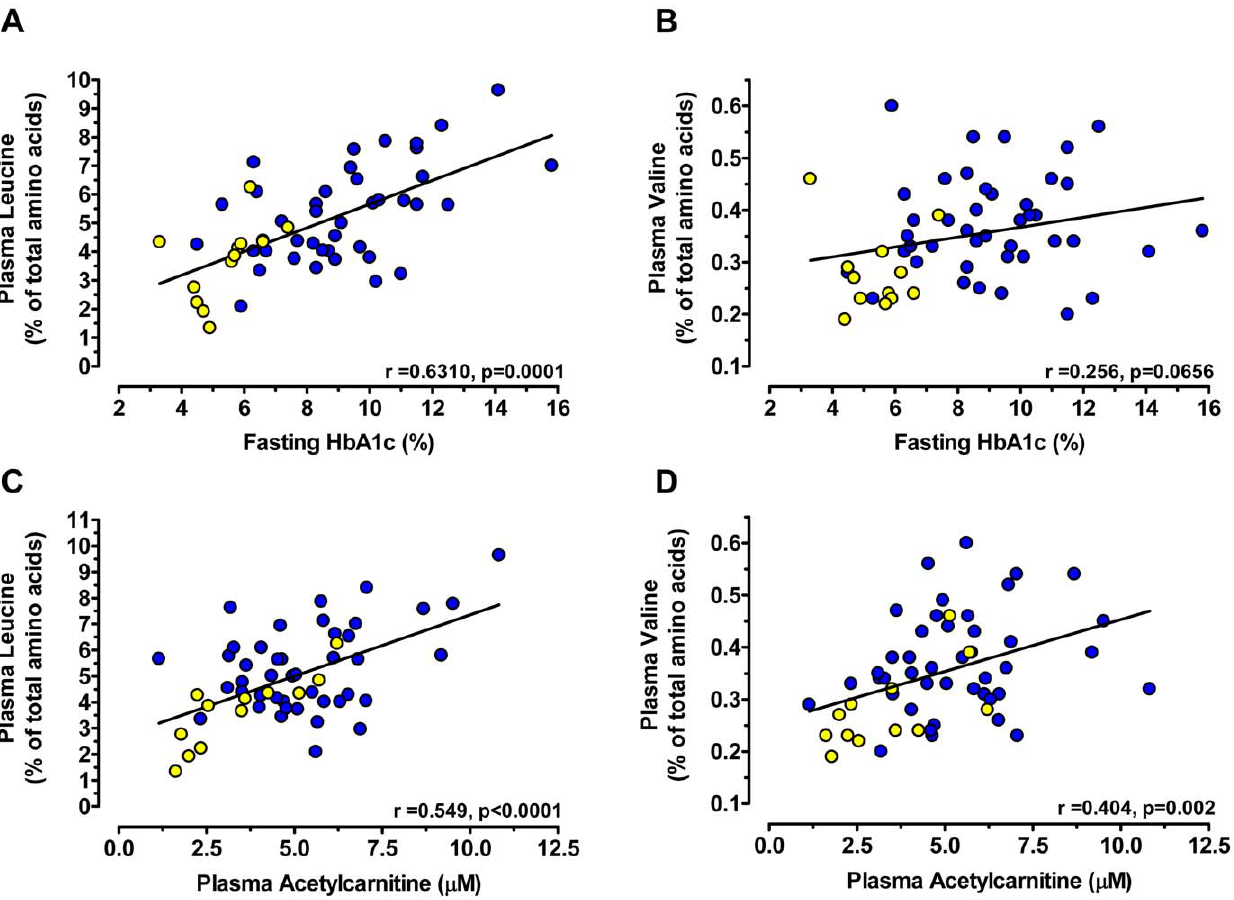
Figure 2. Plasma branched chain amino acid (BCAA) concentrations are correlated with fasting HbA1c% and plasma acylcarnitine concentrations in non-obese (yellow circles) and type 2 diabetic (blue circles) obese women. Shown are correlations between plasma leucine ( A , C ) and valine ( B , D ) enrichments (% of their concentrations relative to total measured amino acid concentrations; see Figure 1 legend) with fasting blood HbA1c (top panels) or plasma acetylcarnitine concentration (bottom panels). Pearson’s r and p values for the correlations are given within the figures.